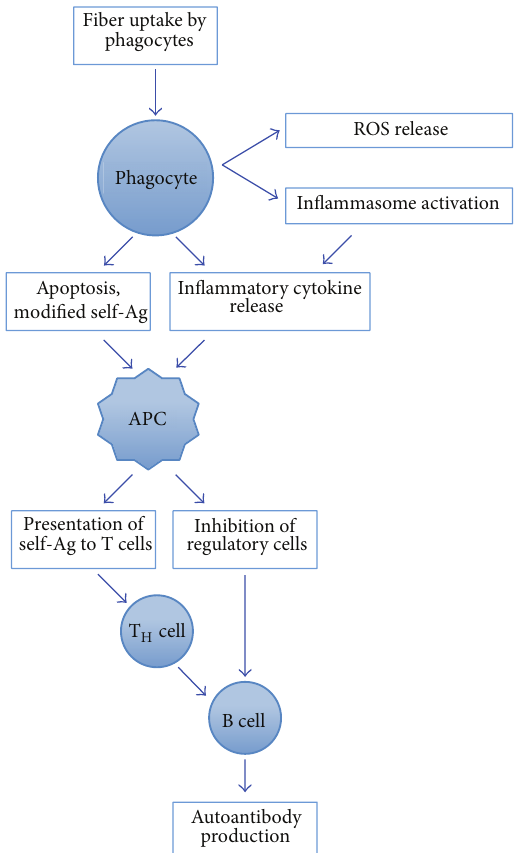
Figure 1: Schematic of possible players in the immune dysfunction by mineral fibers. These are putative mechanisms only. More details on mode of action are covered in excellent reviews mentioned in the text [2, 3, 16,